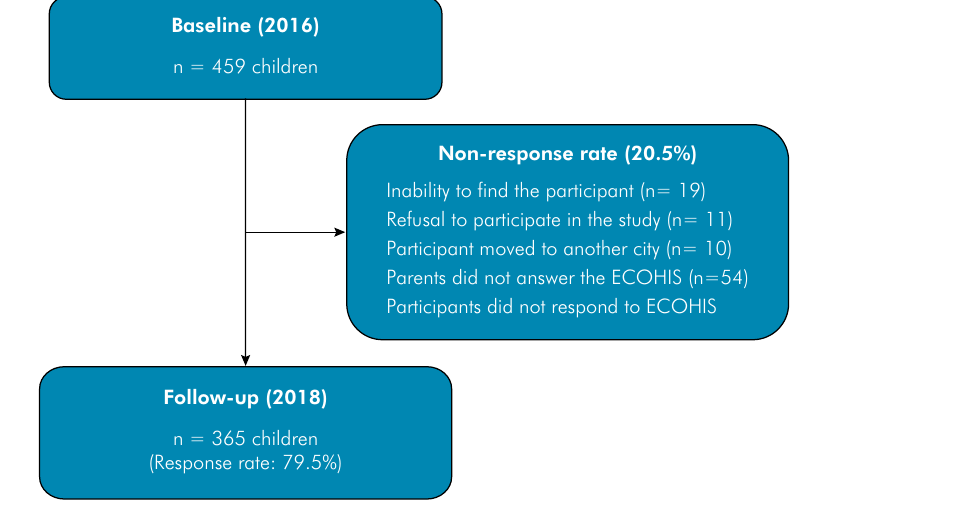
Figure. Flowchart of